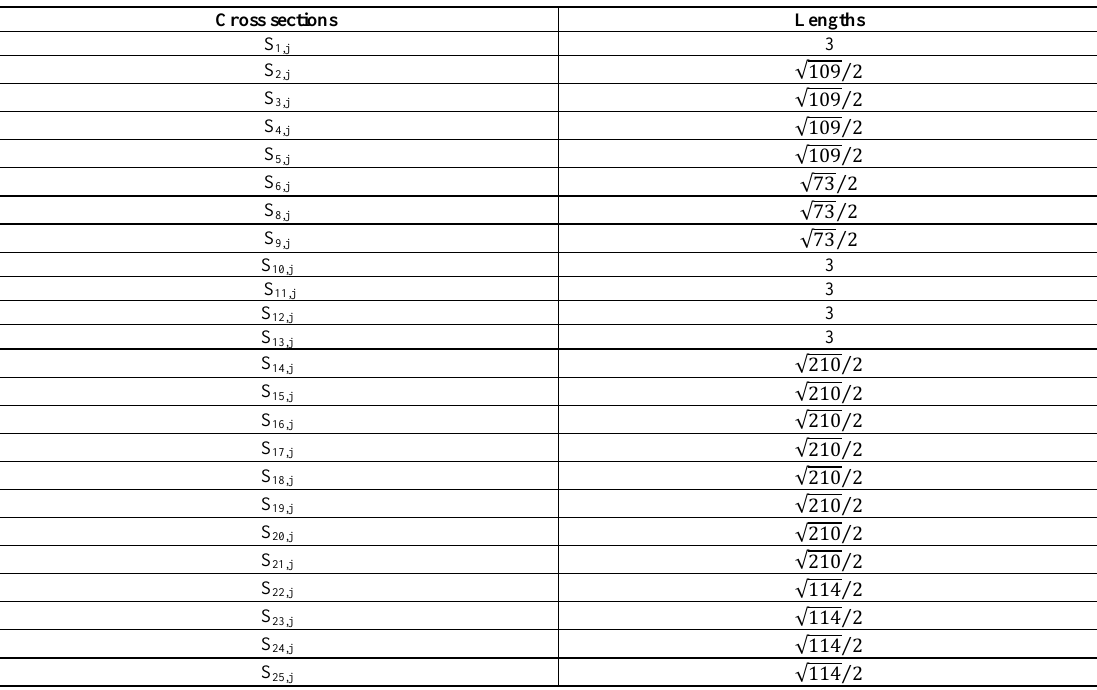
) 𝑖,𝑗 1≤𝑖,𝑗≤25,𝑖≠𝑗